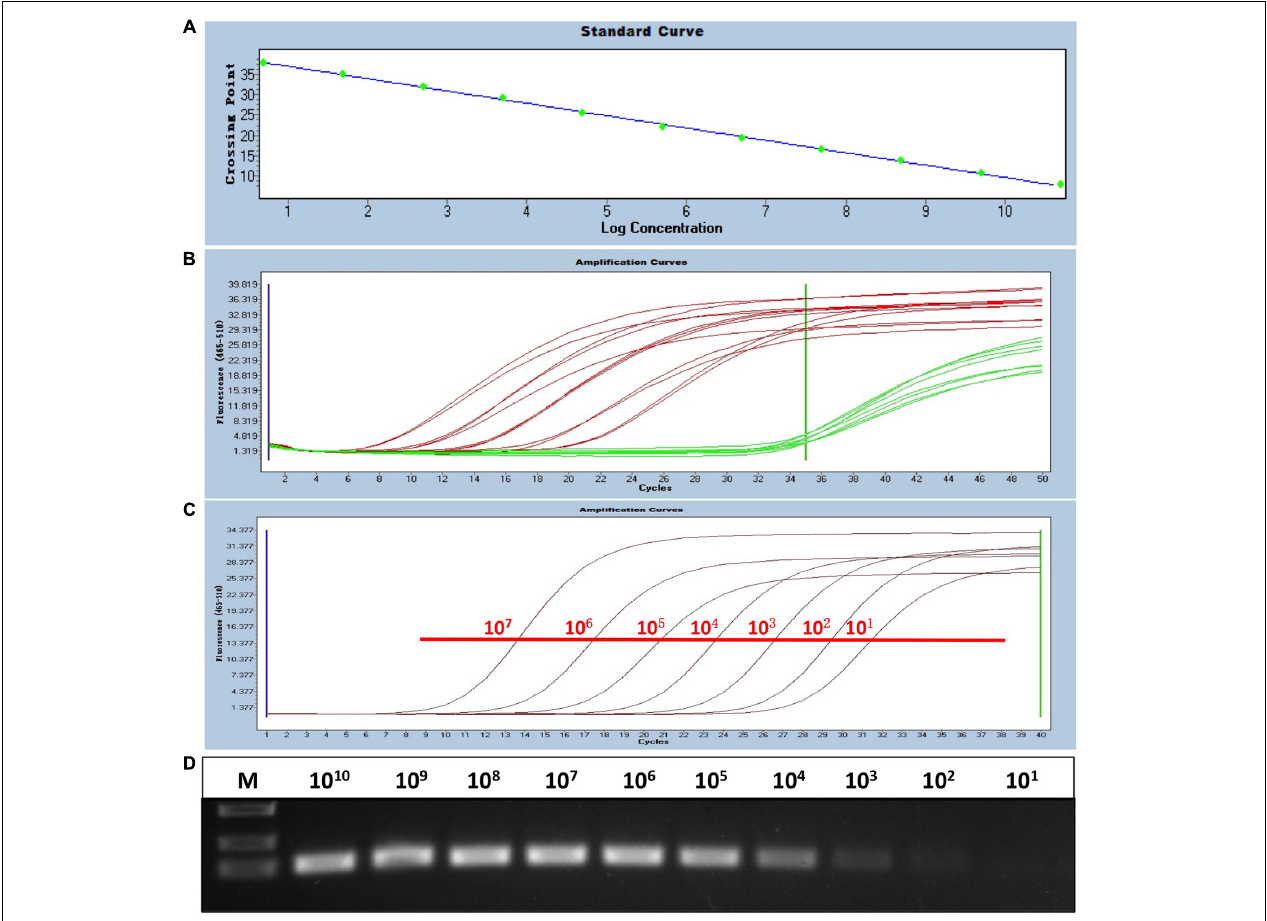
FIGURE 1 | Establishment of the sensitive, FAdV-4-specific real-time PCR. (A) Standard curve of the real-time PCR. The standard plasmid was serially diluted from 1 × 10 1 to 1 × 10 11 copies/ µ l, and a good correlation (error = 0.085, efficiency = 2.152) between CT values and copy numbers was produced. (B) Specificity of the real-time PCR for FAdV-4. Red curves (HLJDAd15 and 11 other FAdV-4 isolates identified by routine PCR) were considered positive, and green curves (FAdV-1, MDV, CAV, AGV2, REV, ALV-A, ALV-B, and ALV-J) were considered negative. (C,D) Sensitivity of the real-time PCR. The detection limit of the real-time PCR (10 1 copies/ µ l) was at least 10-fold higher than that of routine PCR (above 10 2 copies/ µ